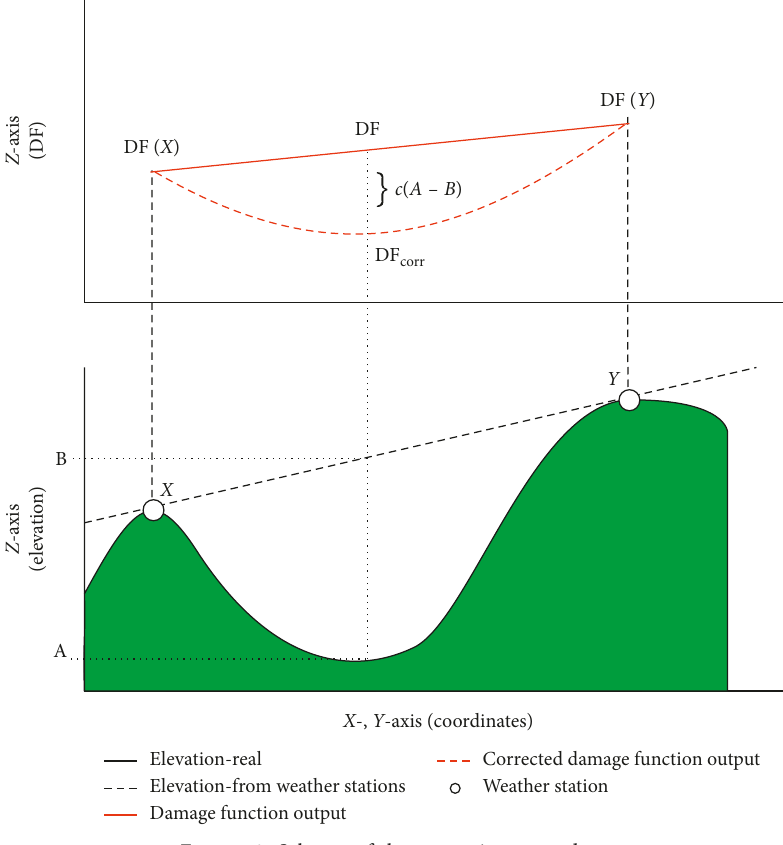
Figure 2: Scheme of the correction